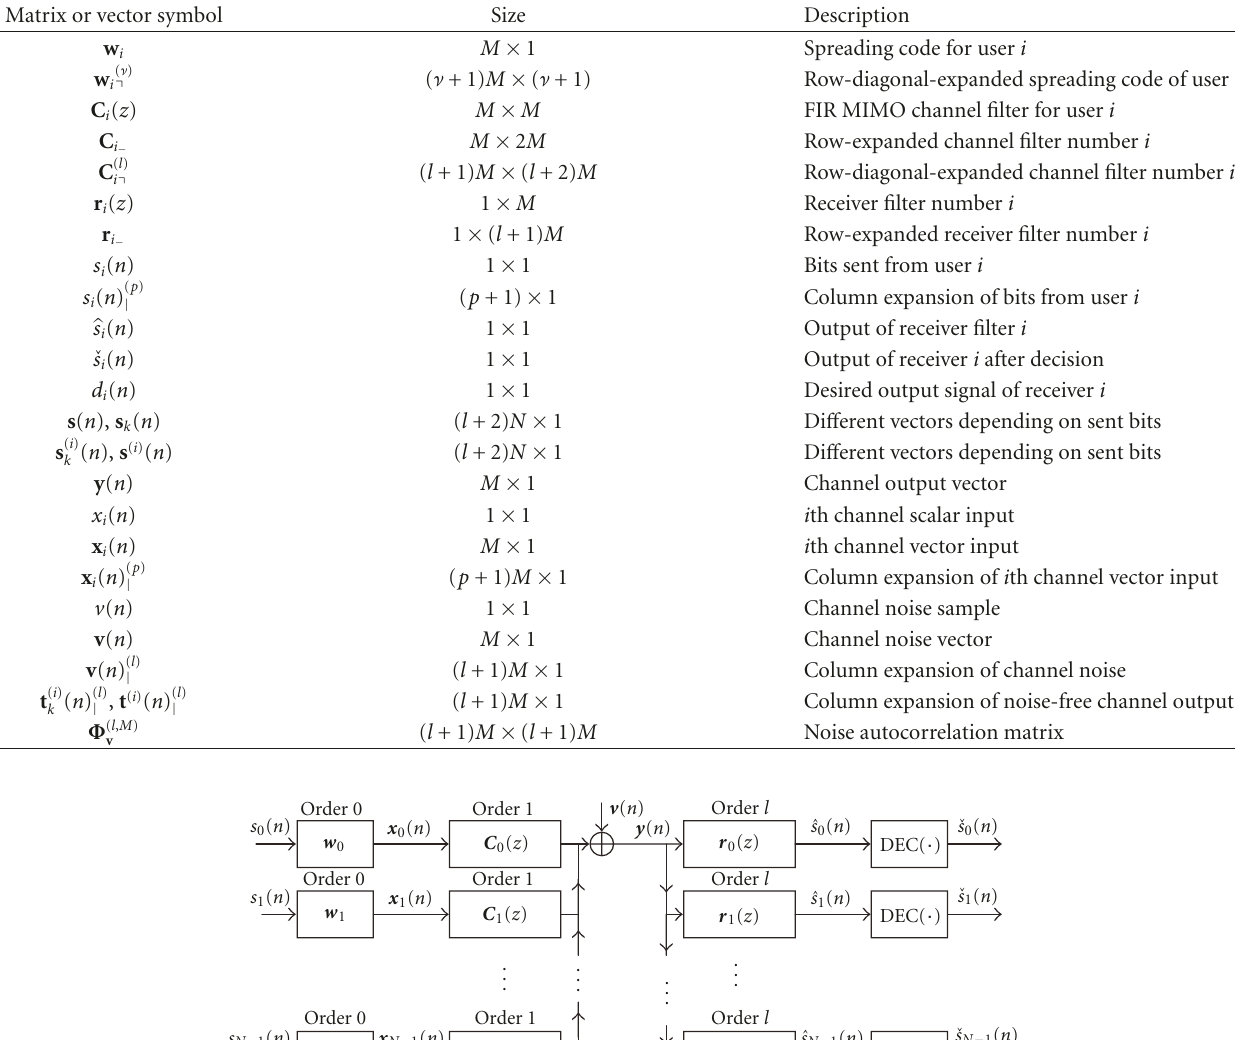
Table 1: Symbols, sizes, and descriptions of widely used quantities.